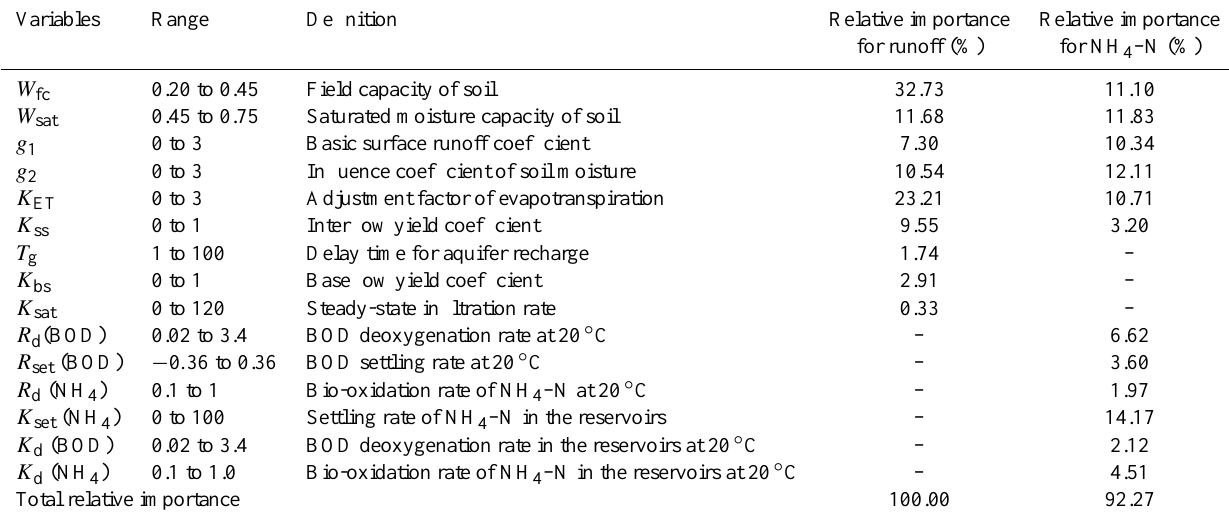
Table 2. Sensitive parameters, their value ranges and relative importance for runoff and NH 4 –N simulations.